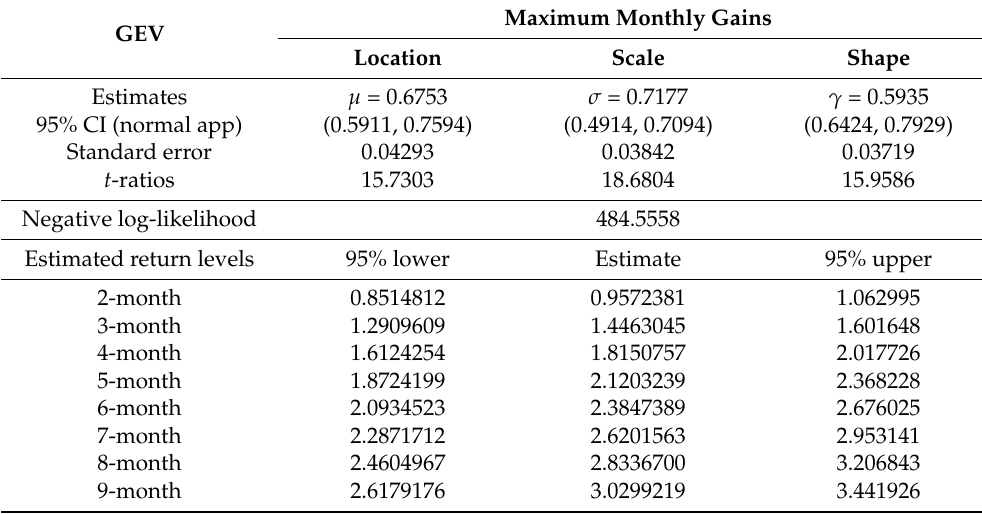
Table 2. Generalised extreme value (GEV) estimates of maximum monthly